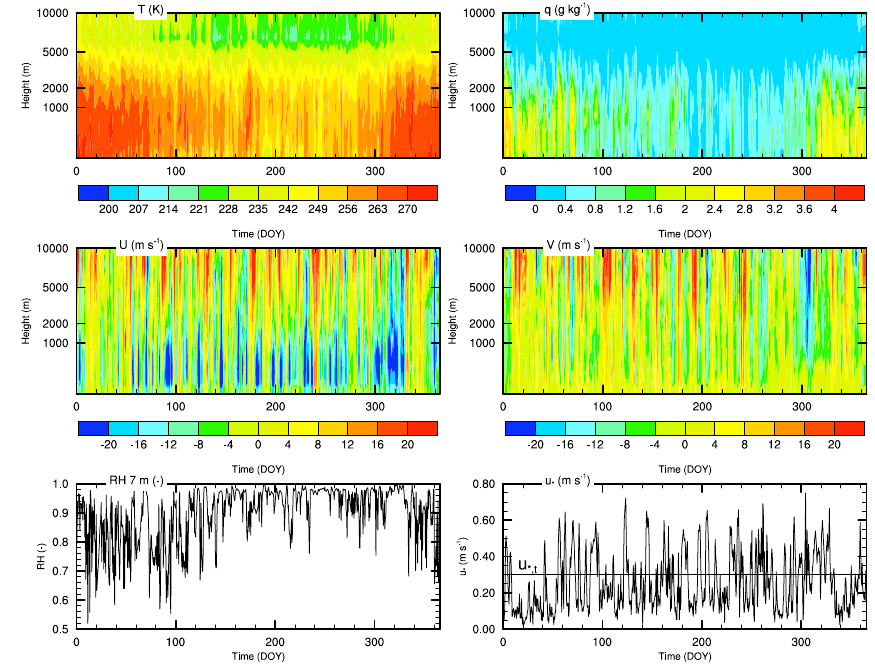
Fig. 3. Time-height sections of temperature ( T ), specific humidity ( q ) and wind speed components ( U and V ) from available radiosonde data and mast measurements at Neumayer, year 1997. The height coordinates are shown according to the vertical resolution in the model, i.e. higher resolution towards the surface. The lowest plot shows the time evolution of RH i at the lowest model level (7m) and the friction velocity u ∗ , together with u ∗ ,t (horizontal